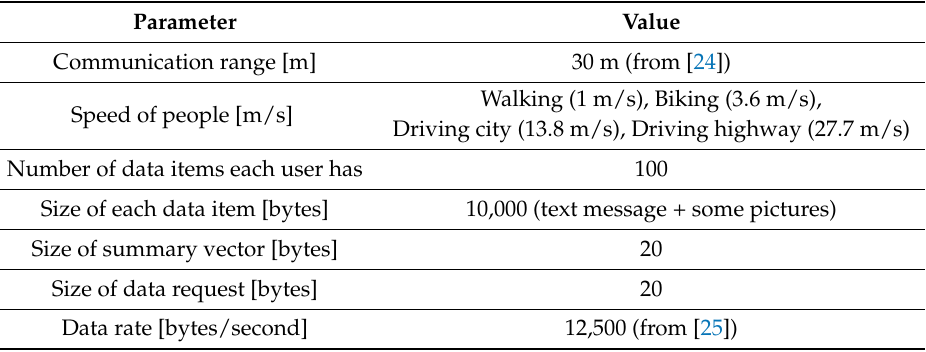
Table 1. Parameters used in our case